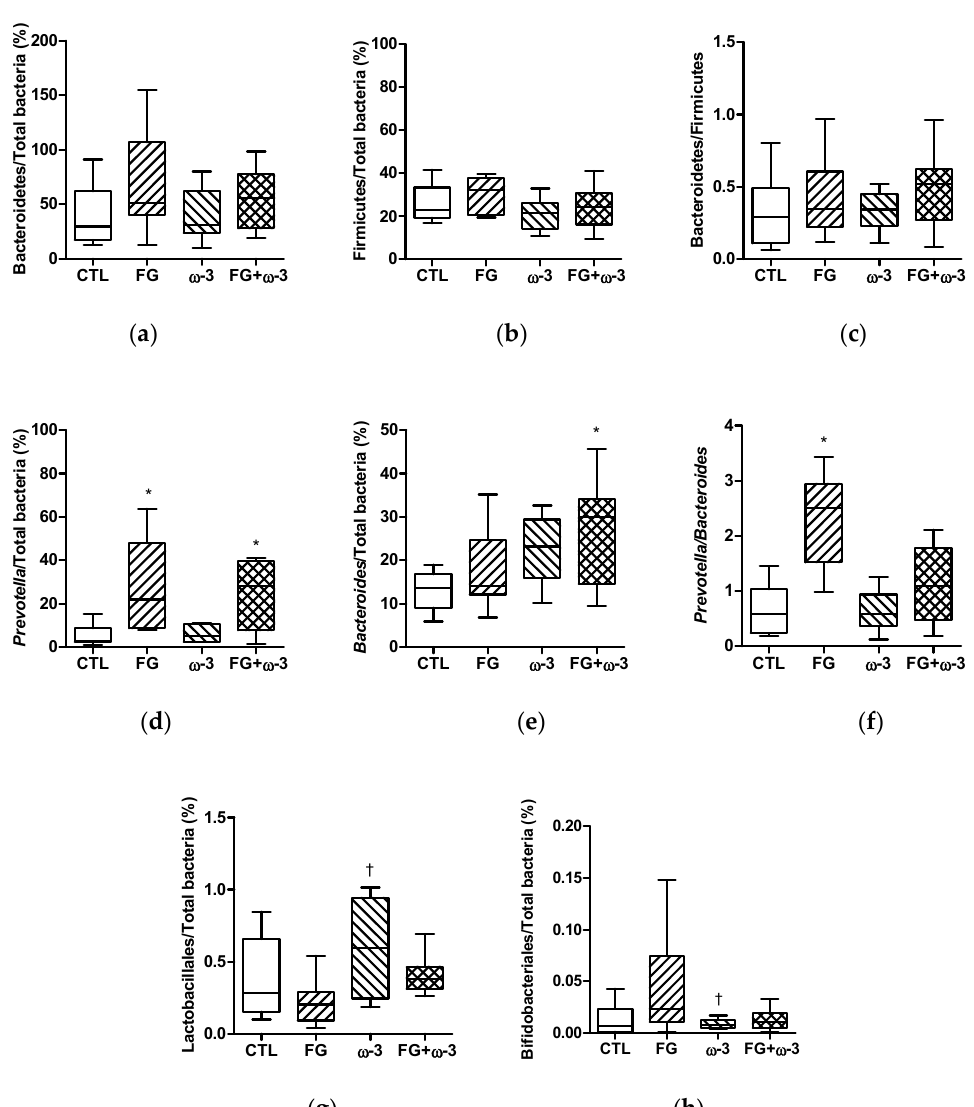
Figure 3. Bacteroidetes ( a ), Firmicutes ( b ), Bacteroidetes:Firmicutes ratio ( c ), Prevotella ( d ), Bacteroides ( e ), Prevotella:Bacteroides ratio ( f ), Lactobacillales ( g ) and Bifidobacteriales ( h ) in fecal samples after 21 weeks, of the different groups (CTL, FG, ω -3 and FG + ω -3) of Sprague–Dawley rats fed a standard diet. Data are presented as means with their standard error. Comparisons were made using one-way ANOVA followed by Tukey's post-hoc test. * p < 0.05 vs. CTL; † p < 0.05 vs. FG.